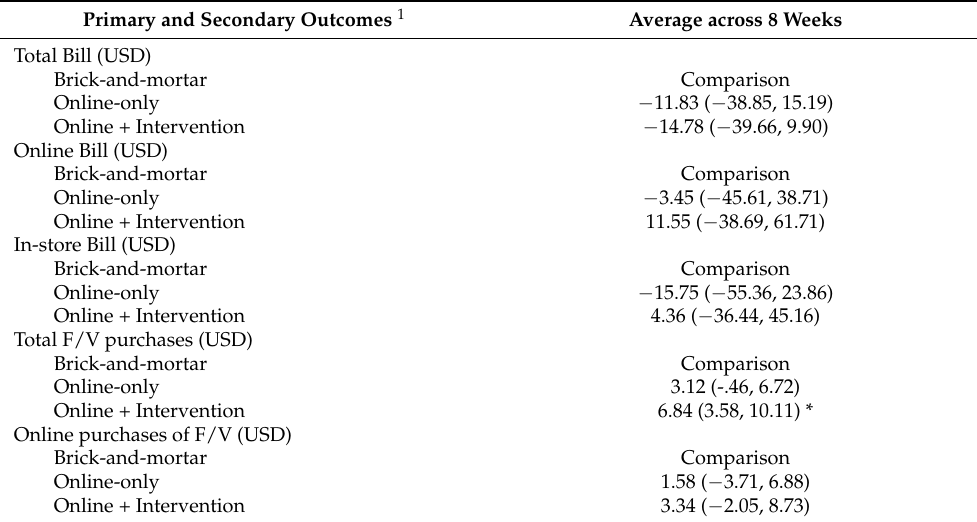
Table 3. Intervention effect on total purchases and purchases of fruits and vegetables across study arms.